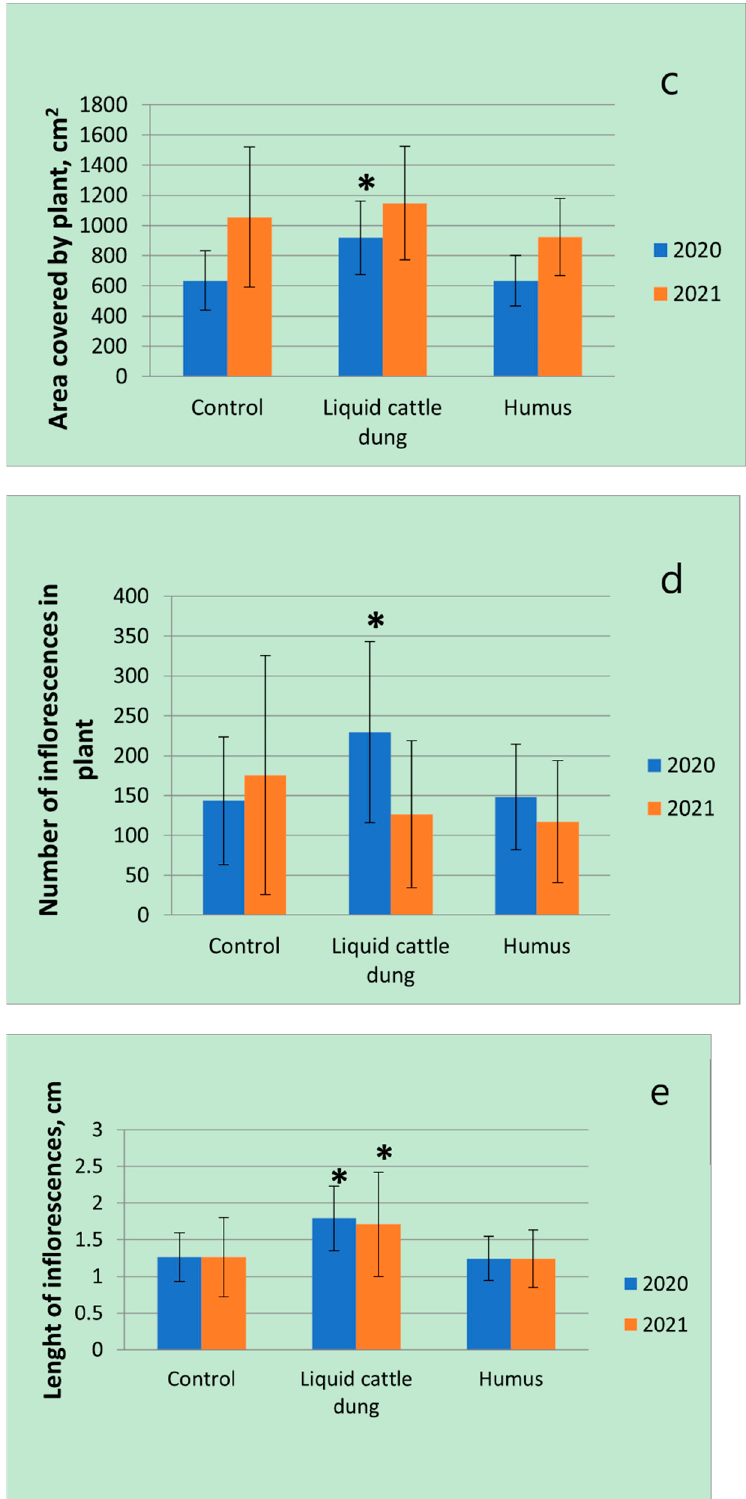
Figure 2. Variations in morphometrical parameters ( a —biomass; b —height; c —area covered by plant; d —number of inflorescences; e —length of inflorescences) of Thymus × citriodorus depending on the fertilization treatment in the first and second experimental years. * denotes statistically significant differences ( p < 0.05); error bars denote standard deviation. FW—fresh weight.